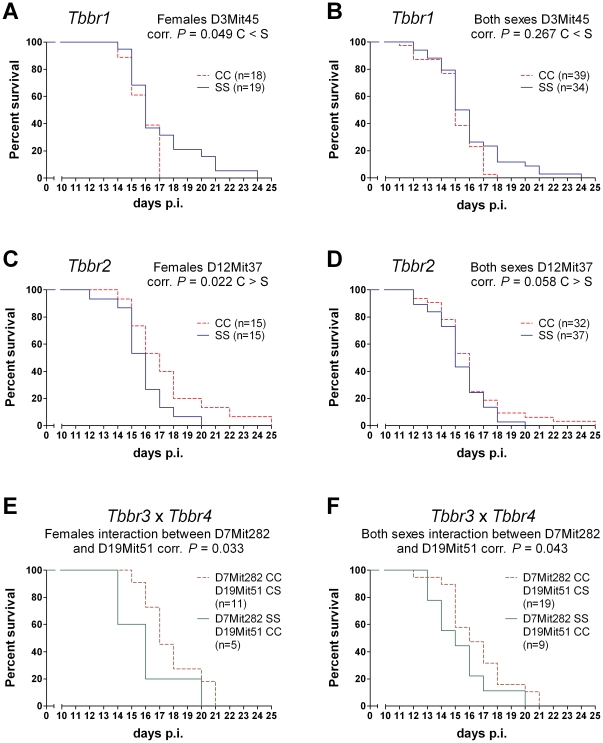
Differential survival of F2 hybrid mice after T. b. brucei infection.Mice were intra-peritoneally inoculated by 2.5×104 bloodstream forms of T. b. brucei. A. females and B. both sexes carrying BALB/c or STS homozygous alleles in Tbbr1 (D3Mit45); C. females and D. both sexes carrying BALB/c or STS homozygous alleles in Tbbr2 (D12Mit37); E. females and F. both sexes carrying interacting STS homozygygous alleles in Tbbr3 (D7Mit282) and BALB/c homozygous alleles in Tbbr4 (D19Mit51) or BALB/c homozygous alleles in Tbbr3 and heterozygotes in Tbbr4. n, number of mice.